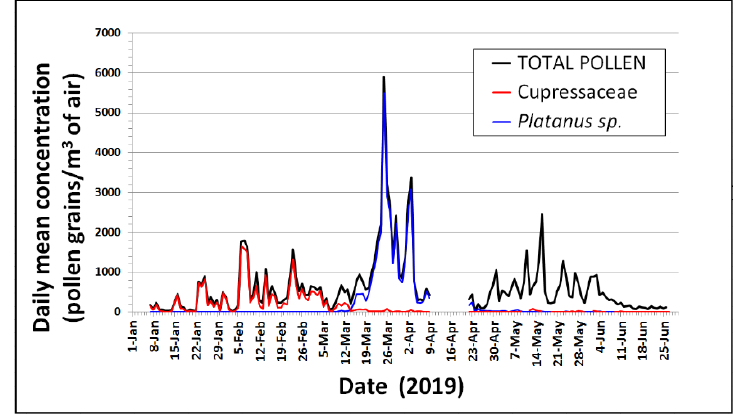
Figure 6. Local airborne pollen (first semester of 2019): comparison of the airborne total pollen with the Cupressaceae and the Platanus sp . contributions. Numerical data gathered from [100].